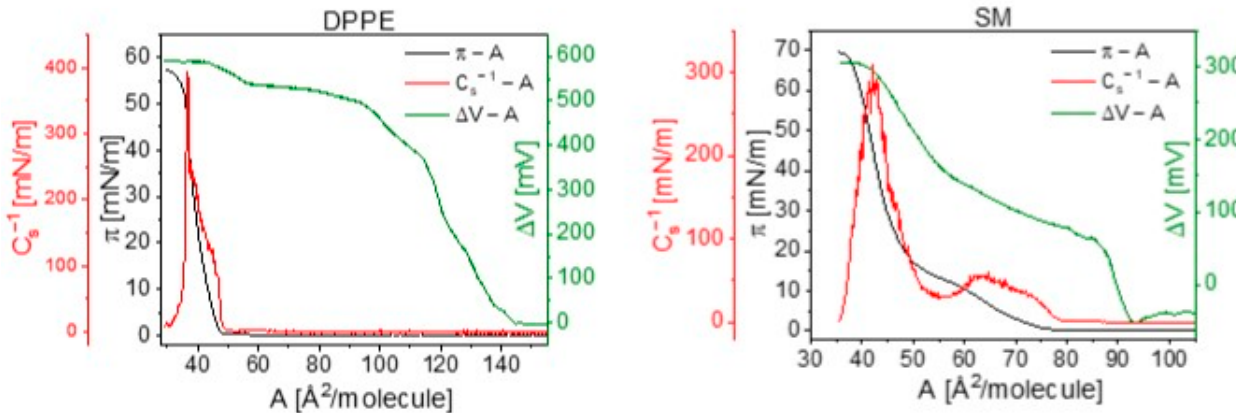
Figure 3. Electric surface potential change and surface pressure isotherms, together with calculated compressional moduli curves for ( A ) DPPE and ( B ) SM.